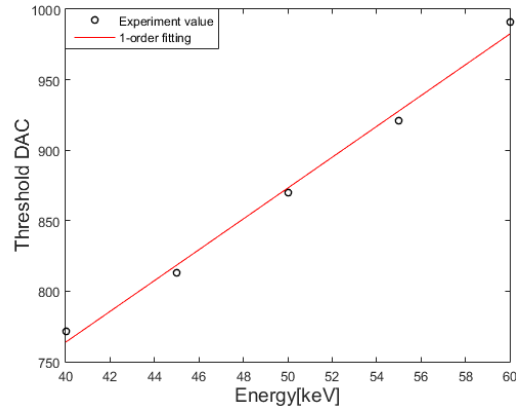
Figure 6. The derived mapping function between the photon energy and the threshold DAC.